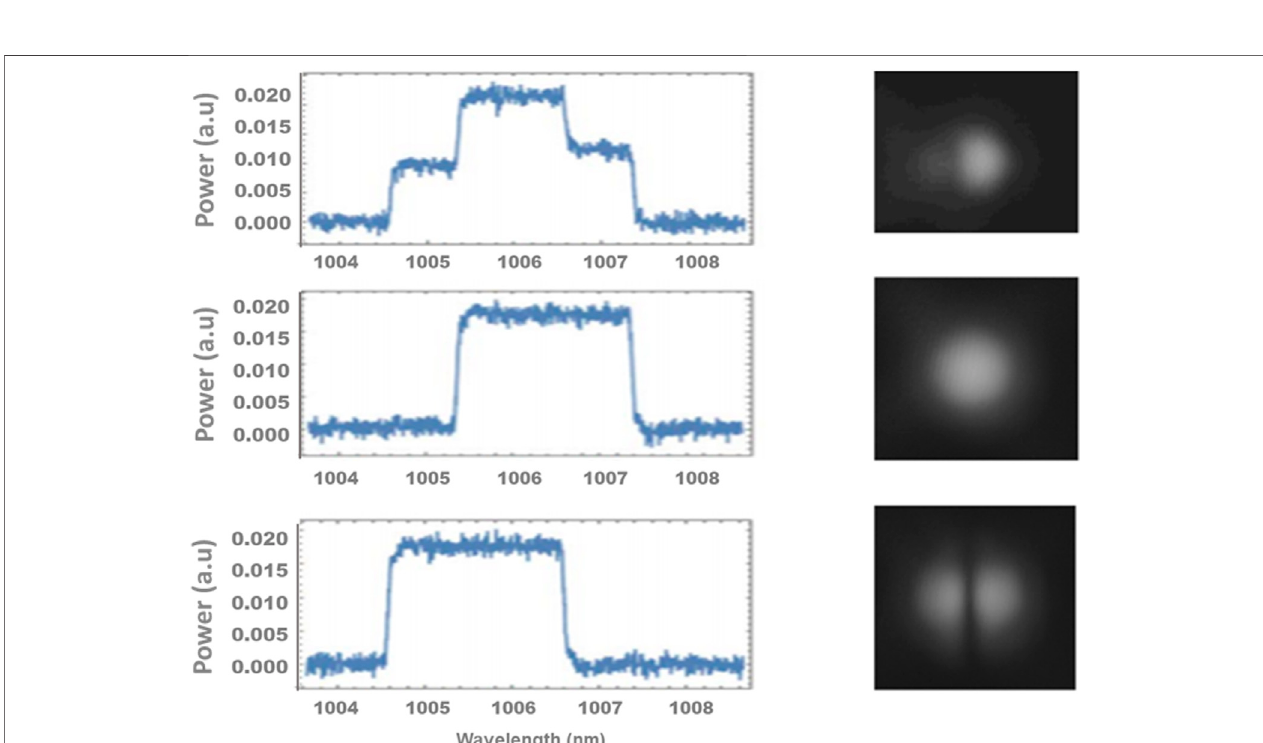
FIGURE 9 | Output pulses of the launched Principal modes, PM1 and PM3.